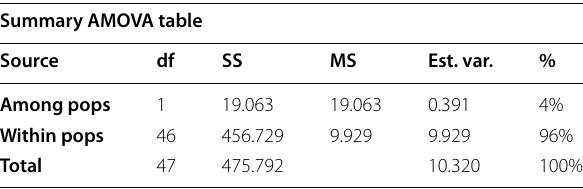
Table 3 AMOVA showing genetic variance within and among